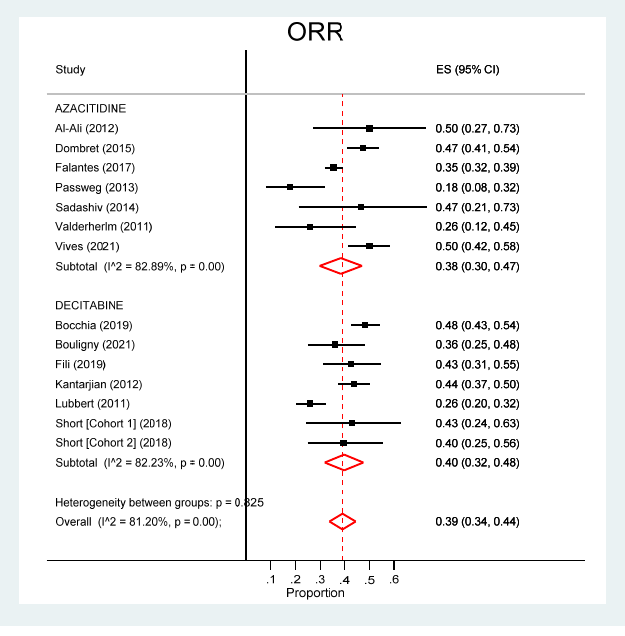
Figure 2. Pooled analysis of the overall response rate (ORR).